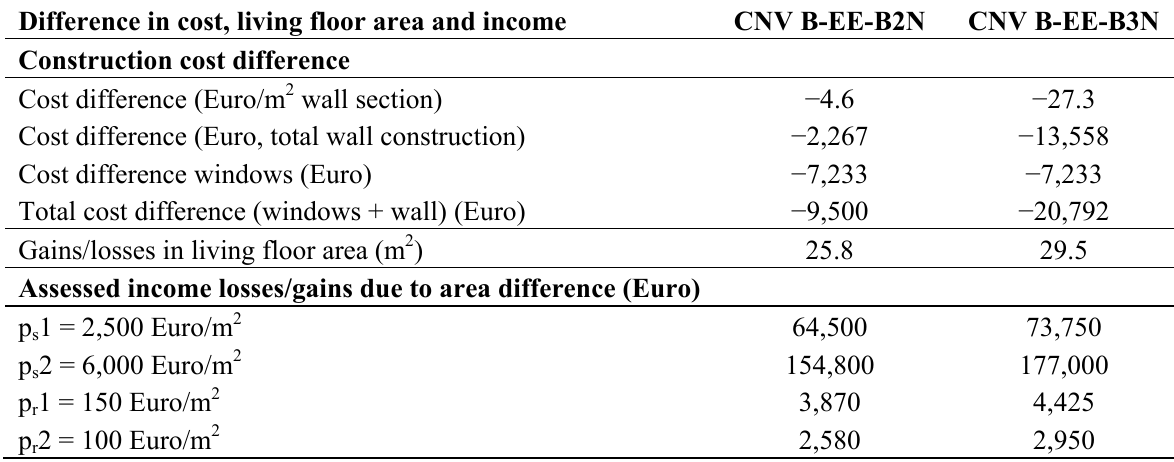
Table A3. Cost difference and assessed living area lost between conventional and energy-efficient building constructed in 2013, brick